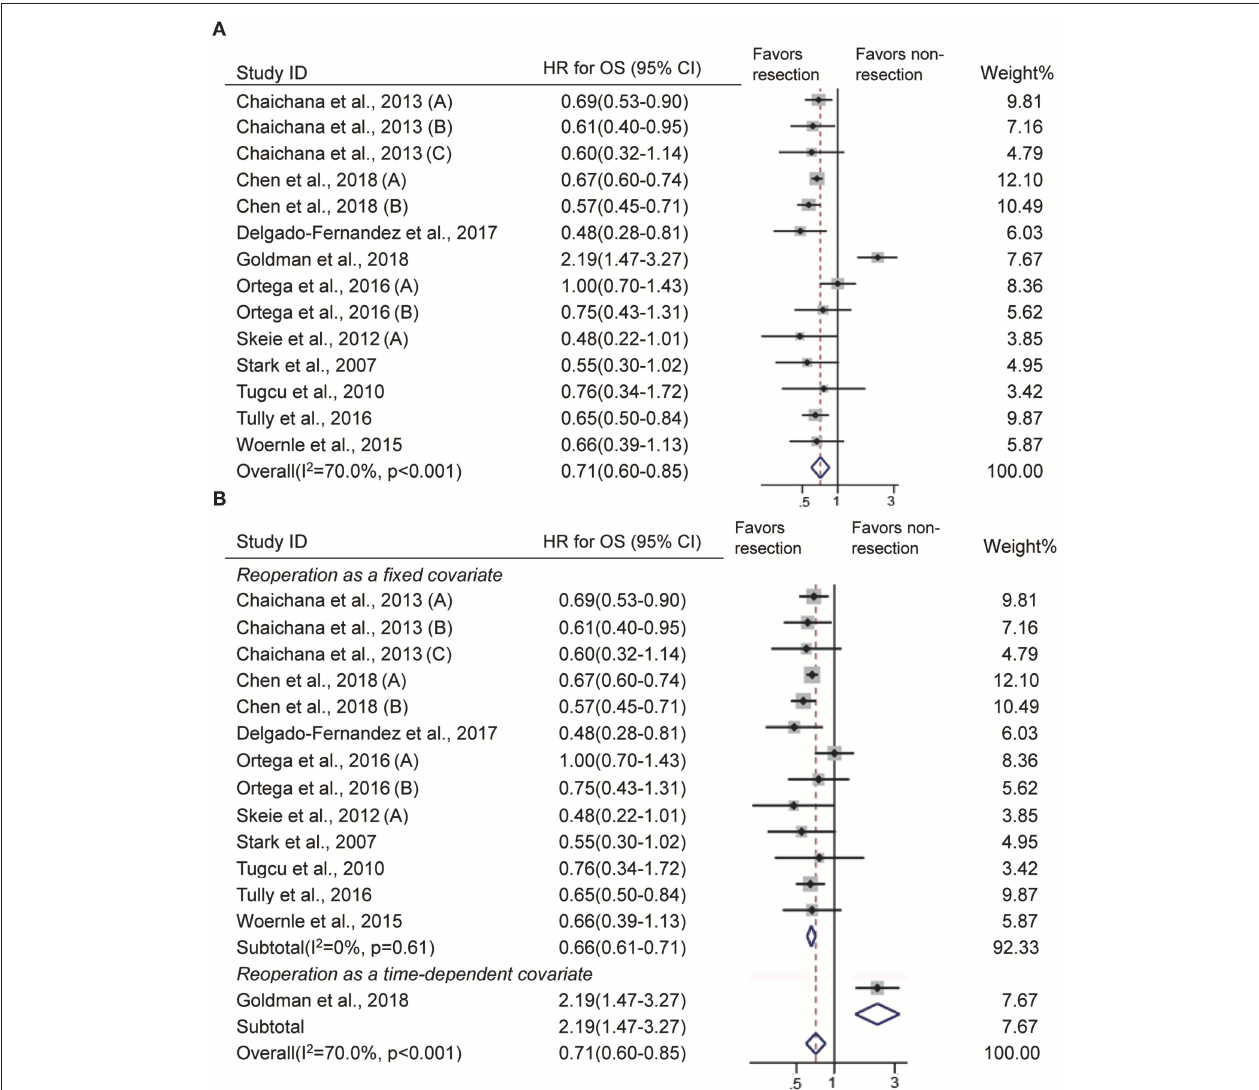
FIGURE 2 | Forest plots showing pooled results of overall survival analysis in recurrent patients with vs without reoperation (A) and when reoperation was considered as a fixed covariate vs. as a time-dependent covariate (B) .